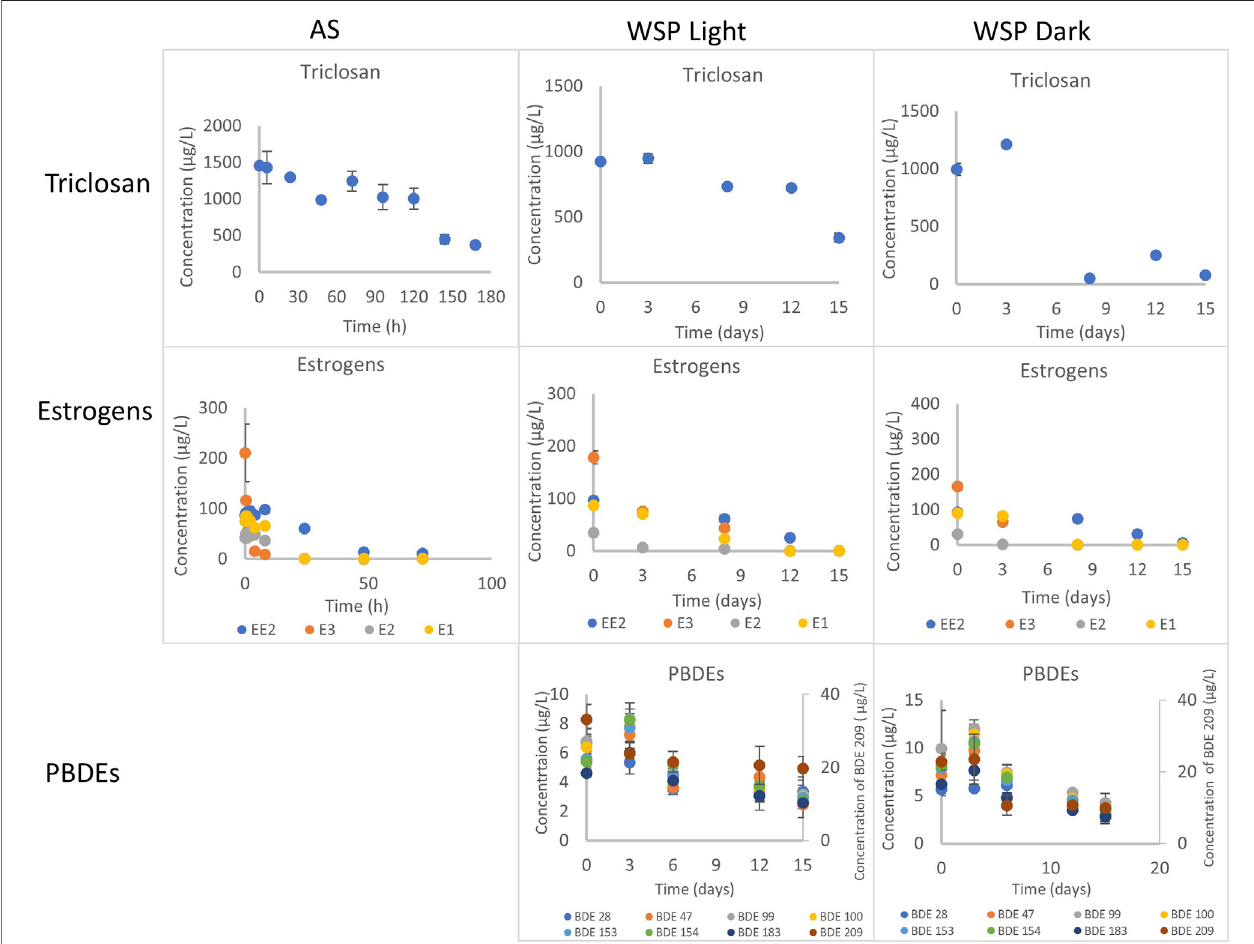
FIGURE 1 | Degradation of triclosan, estrogens and PBDEs under aerobic conditions with activated sludge and facultative inocula in the light and dark. Concentration determined in the combined phase (dissolved and particulate). AS refers to activated sludge, WSP refers to waste stabilization pond.